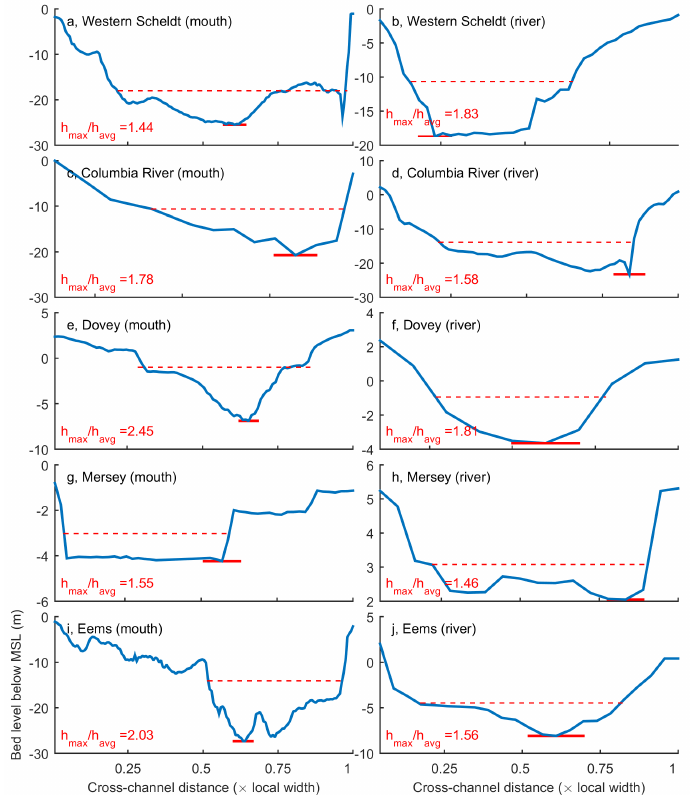
Figure A1. Cross-sectional profiles at the mouth ( left ) and landward river boundary ( right ) for five estuaries. The maximum depth (solid red line) and an approximation of the average water depth (dashed line) are indicated. The ratio between maximum depth and average depth, which is used in Equations (12) and (8), is given in the figures. Average ratio for the geometry of the estuary mouth is 1.85 and for the landward river boundary